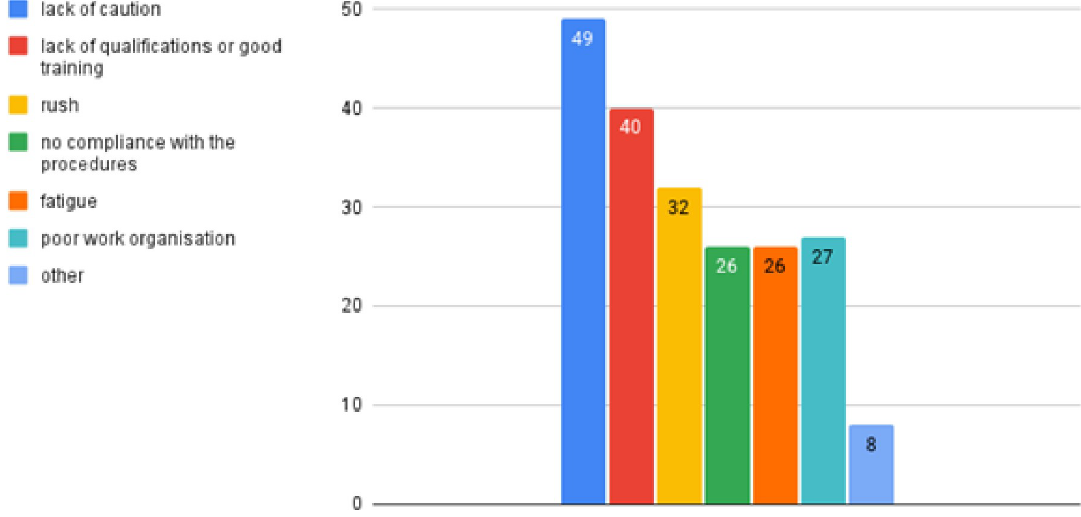
Fig 4. The most common causes of measuring equipment failures due to human factor according to